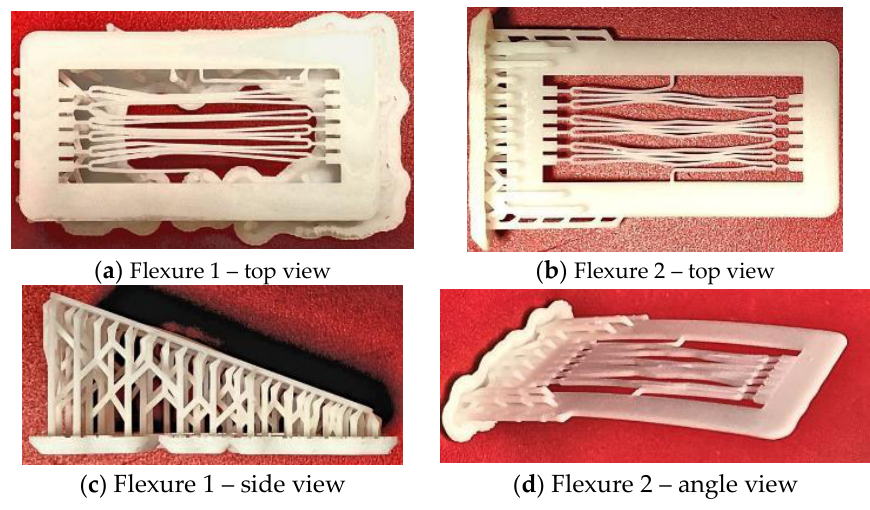
Figure 11. Flexures built with rigid resin—3D printing (Formlabs). Table 4. Cutting parameters for micromachining with Datron Neo CNC Machine.